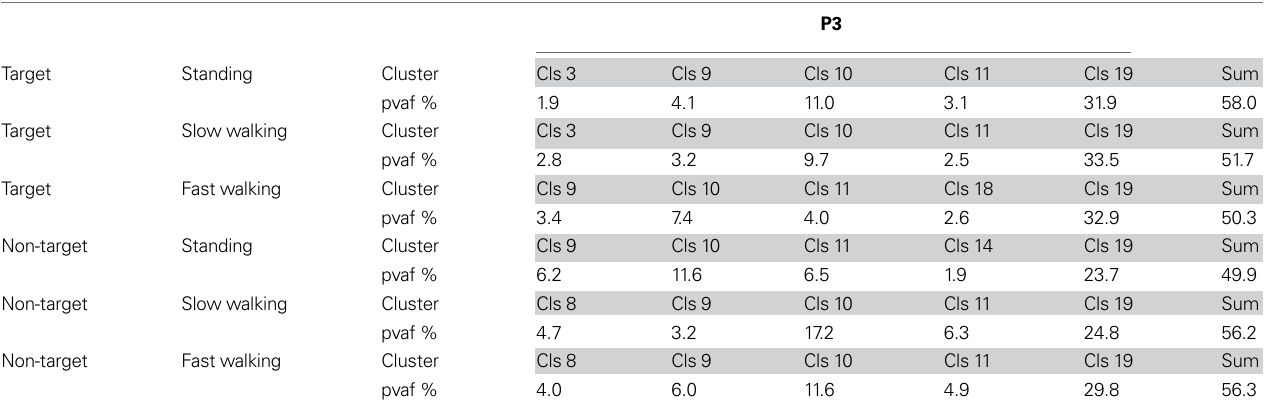
Table S2 | Percent of variance accounted for (pvaf) for the fi ve strongest clusters contributing to the surface measured P3 component, separately for targets and non-target stimuli while standing, slow walking, and fast walking.